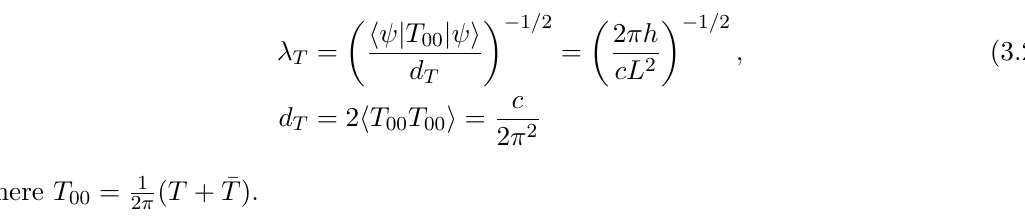
Figure 2 . (a) The cylinder S d frame. (c) The Rindler frame: the conformal frame convenient for the study of the density matrix on subsystem B